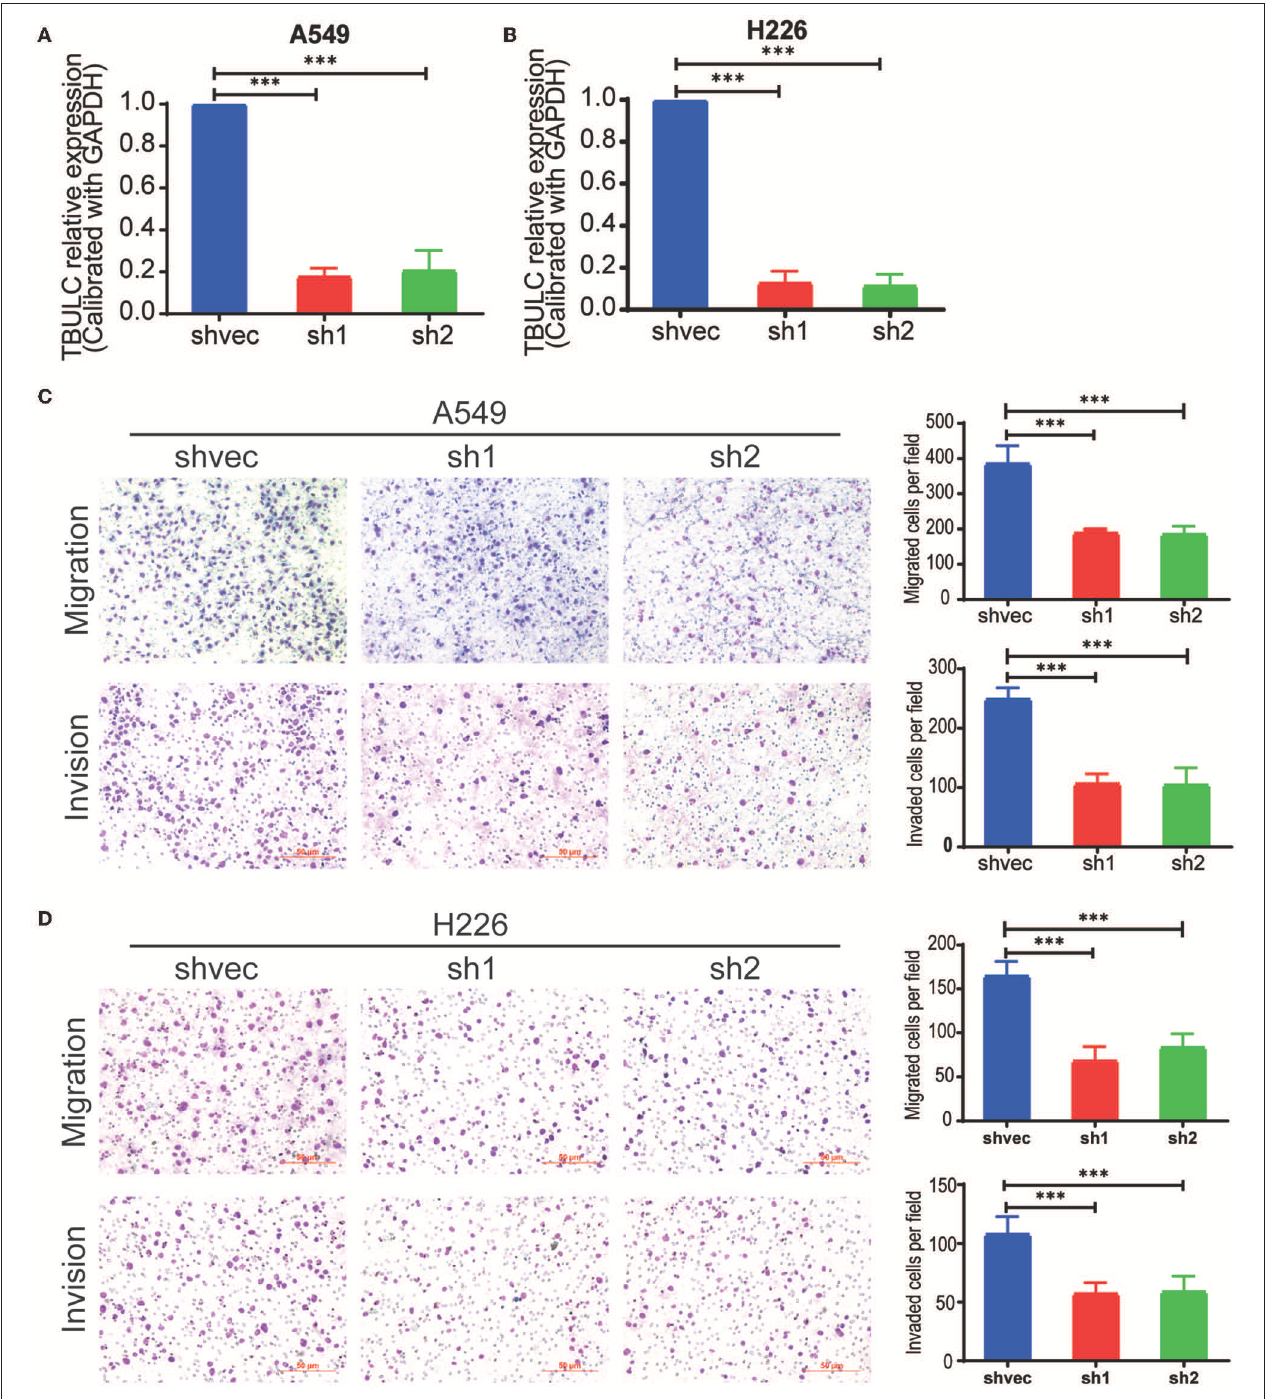
FIGURE 2 | TBULC knockdown inhibited cell migration and invasion in vitro. (A,B) The expression level of TBULC in stable TBULC knockdown or mock vehicle control-transfected (A) A549 and (B) H226 cell clones. (C,D) The migration and invasion ability of TBULC knockdown (C) A549 and (D) H226 cell clones, as detected by the Transwell assay. The numbers of migrating and invading cells were compared between the groups. The data are shown as the mean ± SD. *** p < 0.001.